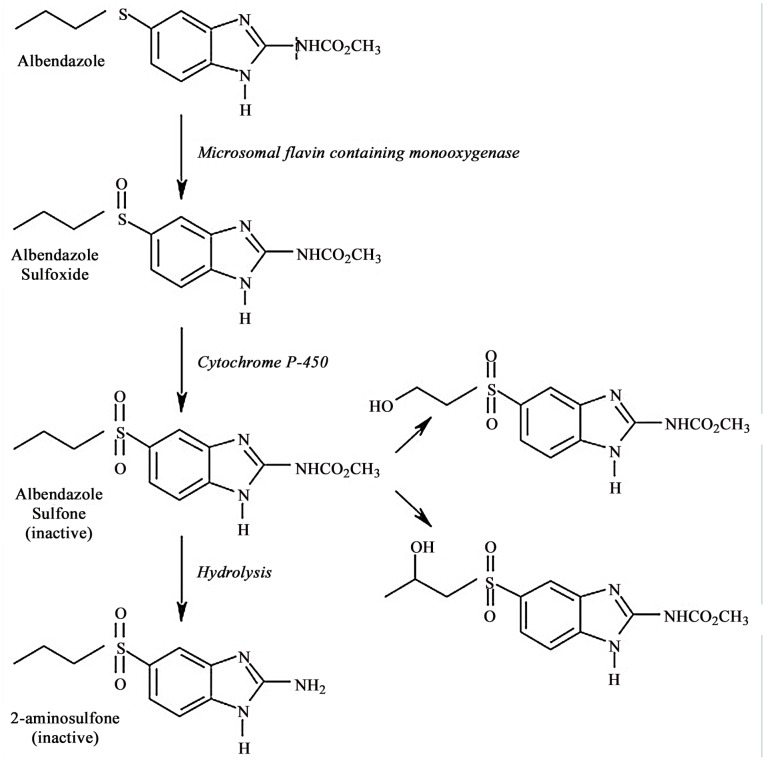
Chemical structure and main metabolic pathways of albendazole and metabolites in organisms (Gyurik et al. [8]).